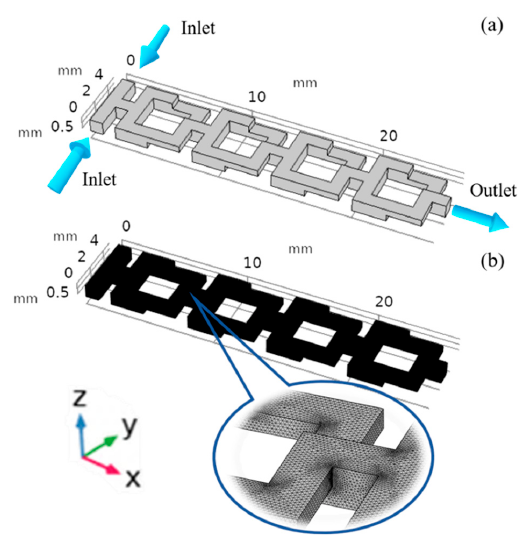
Figure 4. Considering geometry: ( a ) chaotic Baker pipeline model constructed in numerical simula- tion software; ( b ) enlarged view of structured mesh. Table 1. Numerical simulation parameters corresponding to condition number.